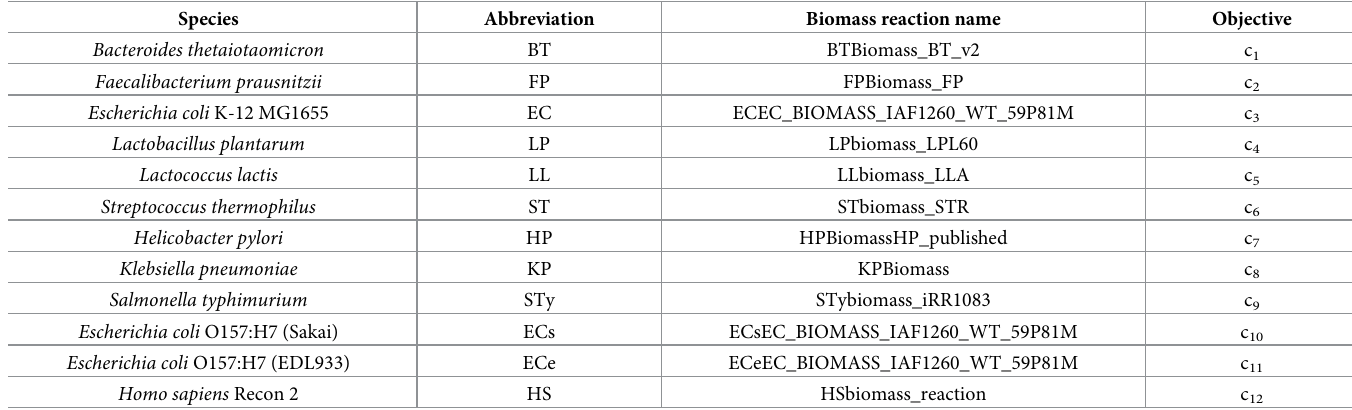
Table 3. Ordered list of biomass reactions chosen as objectives for multi-level linear optimization in FBA for the different species considered in this